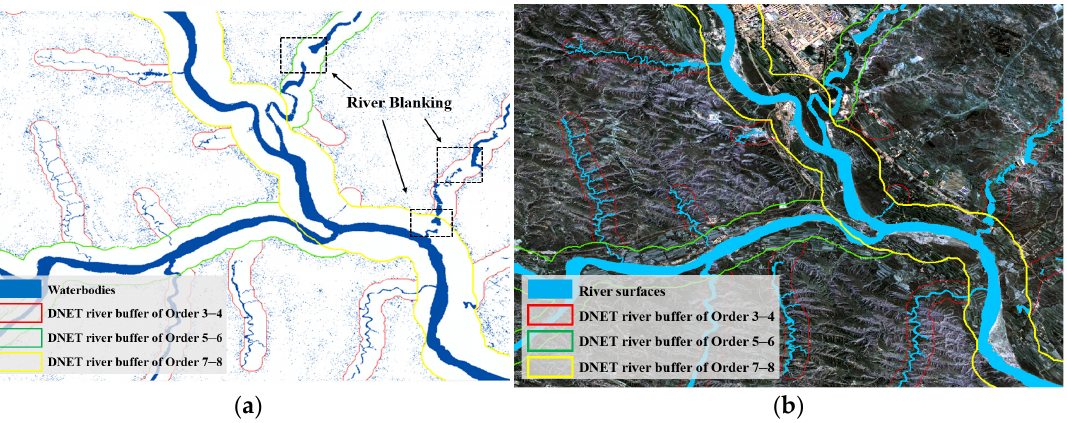
Figure 8. Effect of the river surface denoise. ( a ) Schematic representation of preliminary waterbodies extraction results. River blanking and the noise were shown. ( b ) River network buffer zone constraints and postprocessing results.